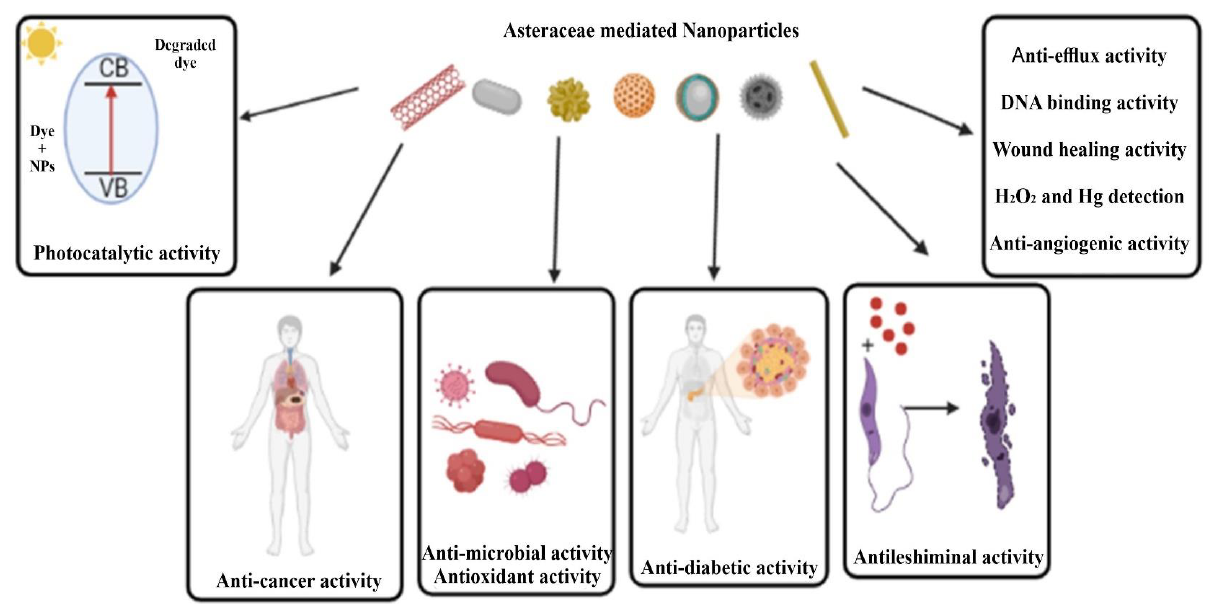
Figure 3. Role of Asteraceae mediated nanostructured materials in effluent treatment, drug delivery, antimicrobial, antioxidant, and other medical diagnoses.